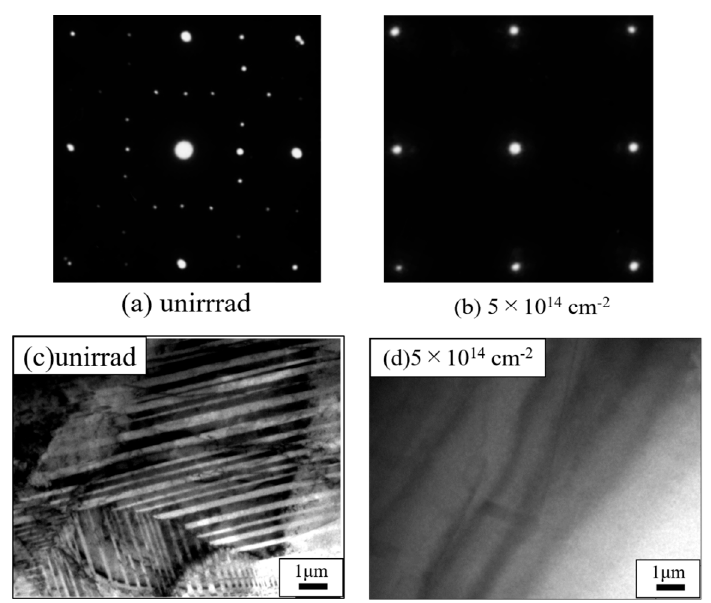
Figure 18. Selected area electron diffraction patterns for ( a ) unirradiated Ni 3 V and ( b ) 16 MeV Au ion-irradiated Ni 3 V. TEM bright field images ( c ) for unirradiated Ni 3 V and (d) for 16 MeV Au ion-irradiated Ni 3 V.